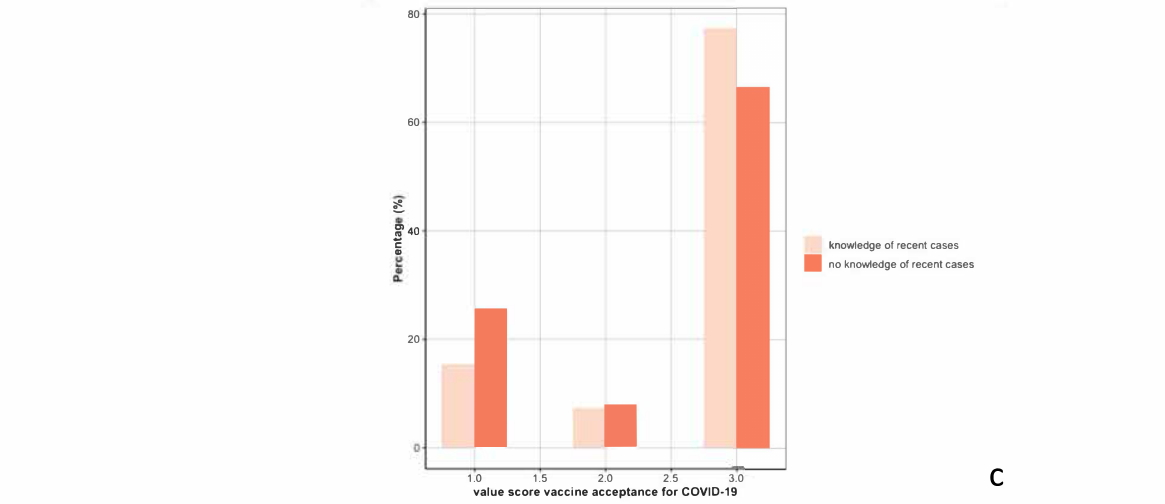
Figure 5. Distribution of vaccine acceptance for cholera ( a ), Ebola ( b ), and COVID-19 vaccines ( c ) by awareness of recent